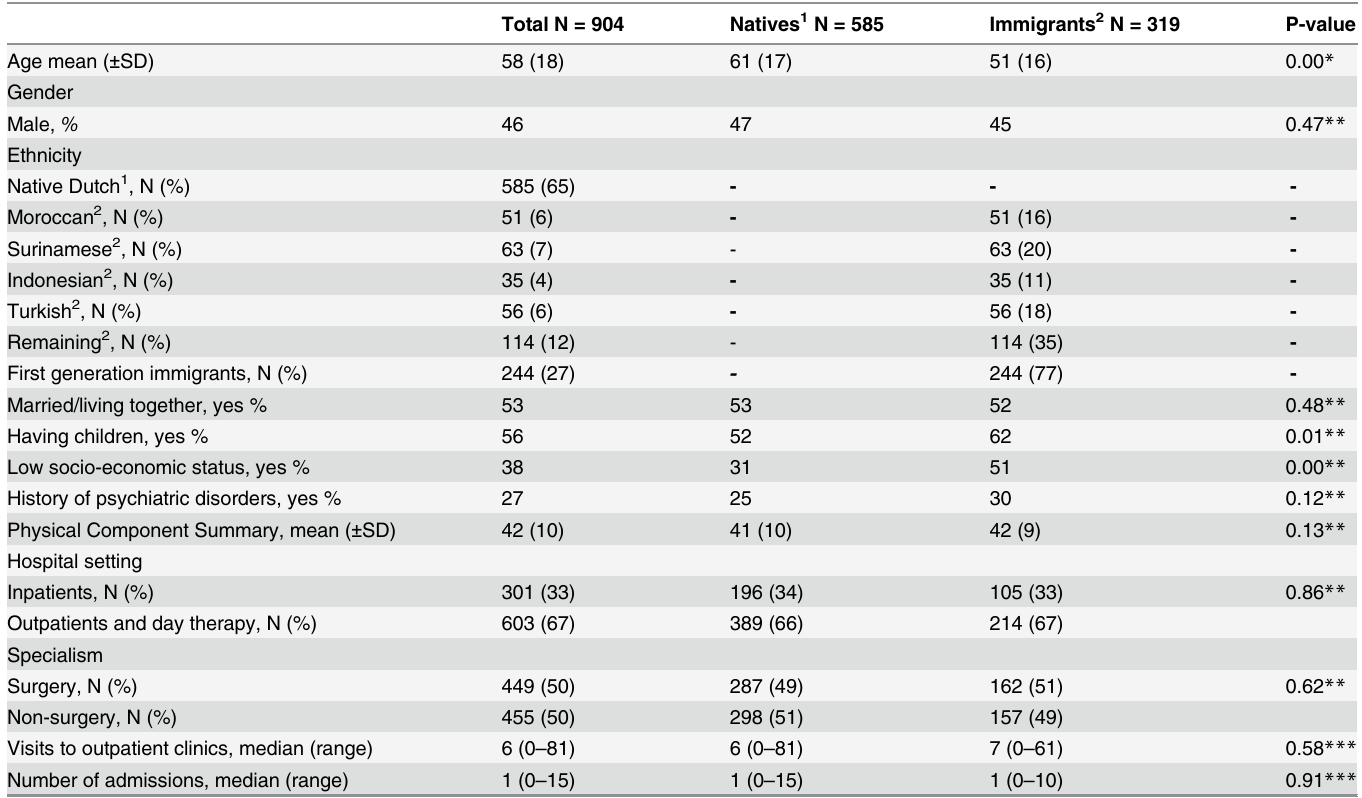
Table 1. Baseline characteristics of the native and immigrant